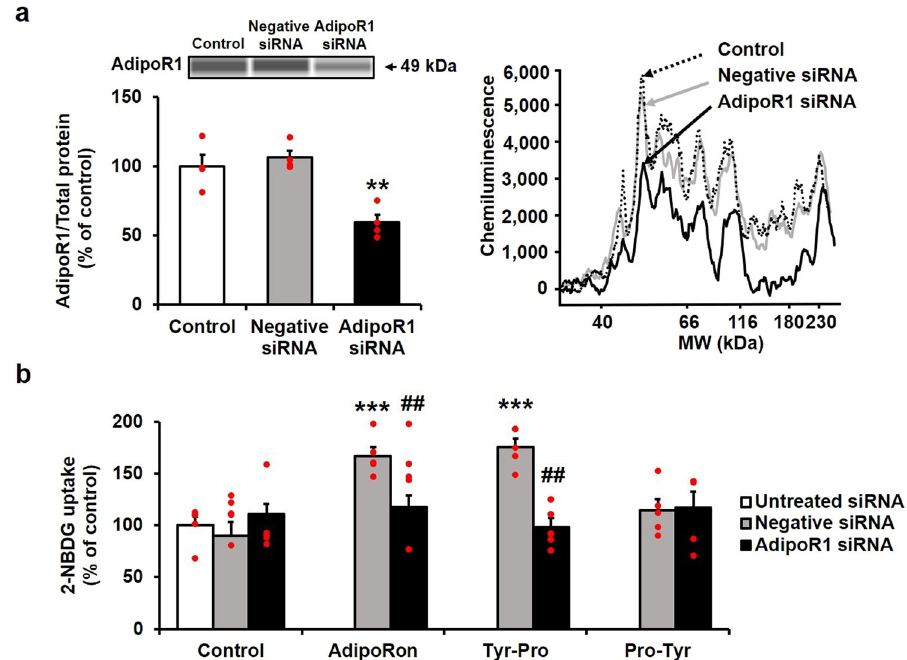
Fig. 3 Involvement of the AdipoR1 receptor in promoting 2-NBDG uptake in L6 myotubes by Tyr-Pro. a AdipoR1-knockdown of L6 myotubes by AdipoR1-speci fi c siRNA transfection. The AdipoR1 protein level was measured using the Wes instrument. The chemiluminescent signal is displayed as a virtual blot-like image, and an electropherogram is generated based on molecular weights. b The effect of AdipoR1- knockdown in L6 myotubes on the promotion of 2-NBDG uptake by dipeptides. The knocked-down L6 myotubes were incubated with 1 µM Tyr-Pro or 1 µM Pro-Tyr for 1 h for 2-NBDG uptake experiments. AdipoRon (0.1 µM, 0.5 h) was used as a positive control to validate the knockdown of AdipoR1 in L6 myotubes. Results are expressed as the mean ± SEM ( n = 4 – 5). Statistical differences were evaluated using Dunnett ’ s t -test. ** p < 0.01, *** p < 0.001 vs. control. Statistical differences between negative and AdipoR1 siRNA groups were evaluated by unpaired two-tailed Student ’ s t -test. ## p <